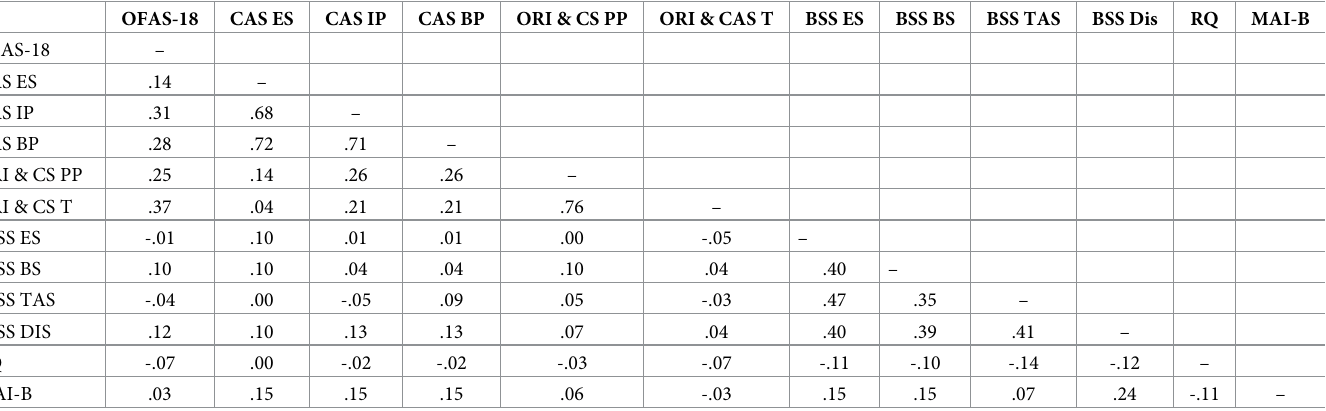
Table 2. Zero-order correlations for all